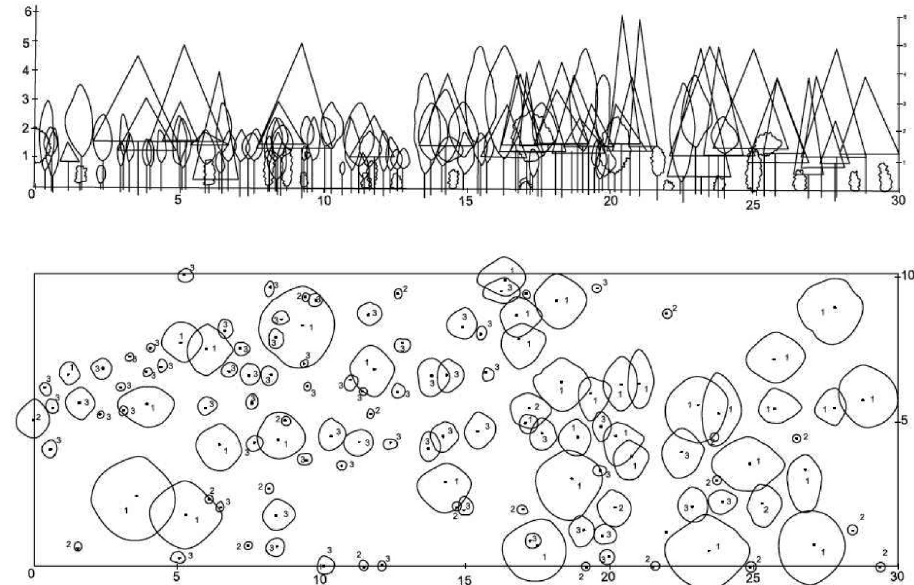
Figure 3. Representative vertical and horizontal profile of the mixed P. brutia stands on northern aspects. 1 = P. brutia , 2 = Q. pubescens , 3 = C. sempervirens .